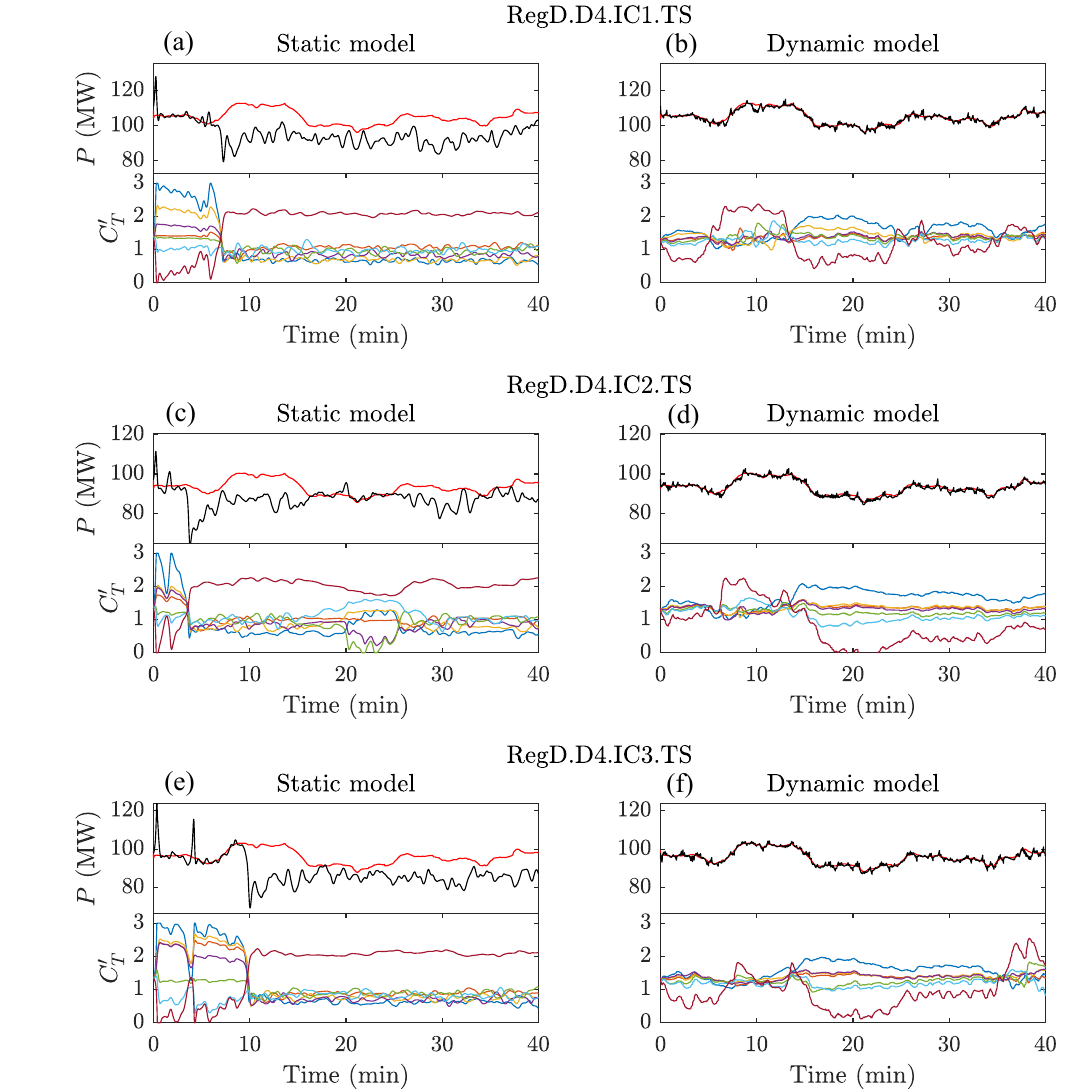
Figure 6. Comparison of static-model (a, c, e) and dynamic-model (b, d, f) control methods for RegD test signals with 4% derates. All three initial conditions are shown from top to bottom. The top plot in each panel shows the controlled LES wind farm model power produc- tion (black) compared to the reference signal (red). The bottom plot in each panel shows the local thrust coefficients calculated with control methods by row: row 1 (dark blue), row 2 (orange), row 3 (yellow), row 4 (purple), row 5 (green), row 6 (light blue), and row 7